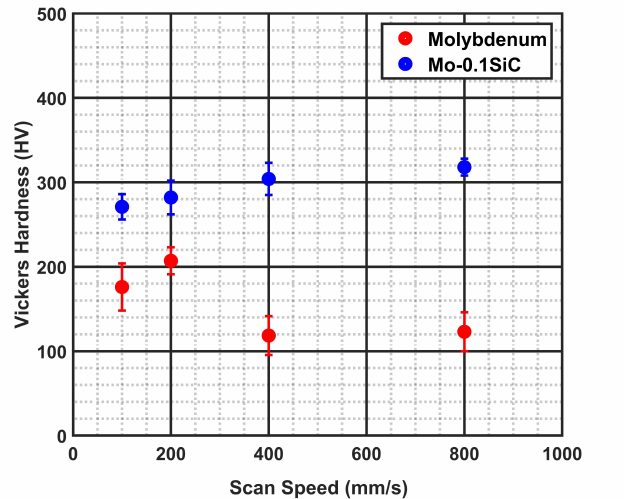
Figure 11. Nanoindentation hardness values for pure molybdenum and Mo-0.1SiC at the four differ- ent scan speeds. The error bars represent the standard deviation of the forty individual indentations made on each